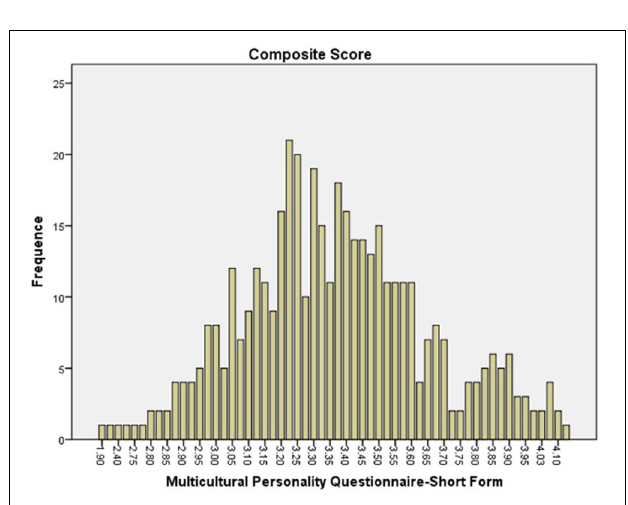
FIGURE 3 | Emotional Stability mean scores.